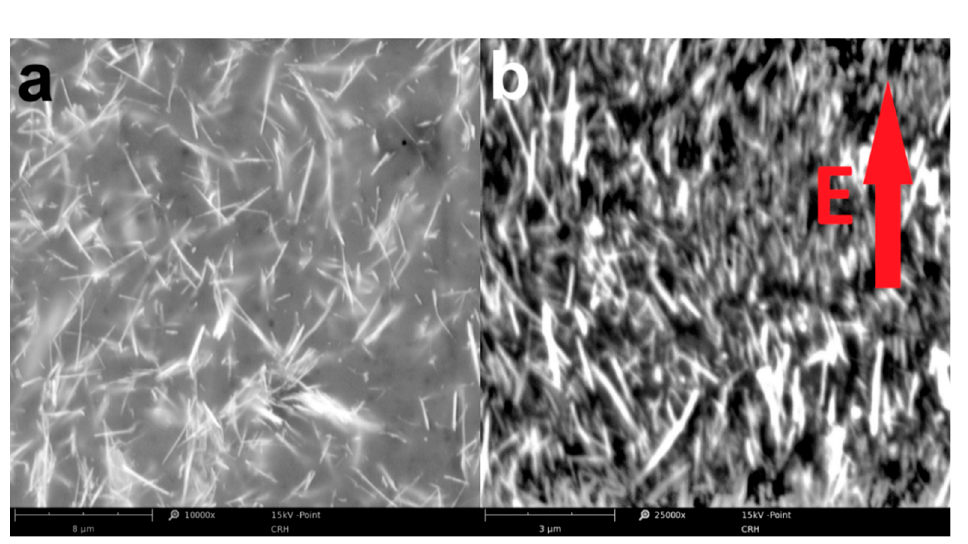
Figure 7. Cross-section SEM micrographs of ESNC with 40% weight concentration of SbSI nanowires cured without ( a ) and under ( b ) electric field with an intensity of 10 kV/cm. The arrow represents the direction of the external electric field applied during the curing process.